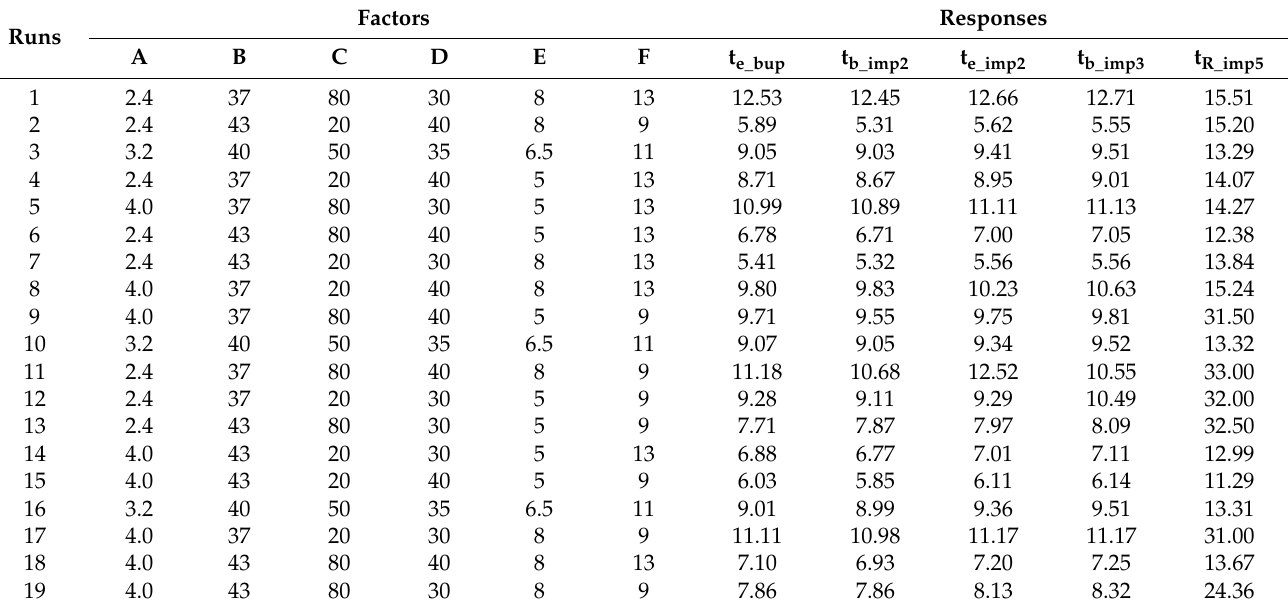
Table 1. Plan of experiments defined by 2 6-2 fractional factorial design and the obtained